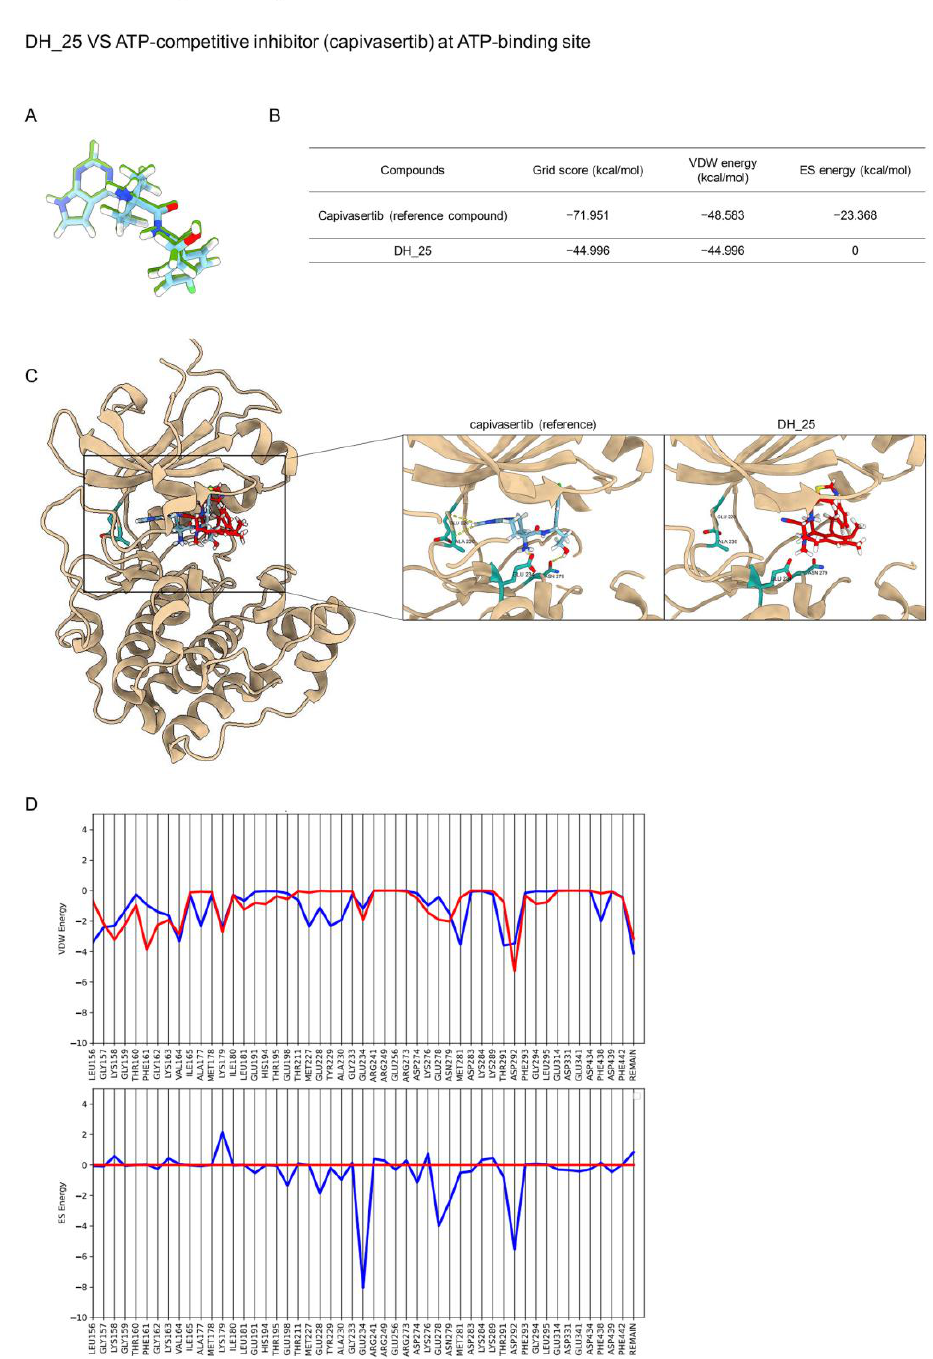
Figure 5. Molecular docking of DH_25 and Akt at the ATP-binding site compared with the ATP-competitive inhibitor (capivasertib). ( A ) Structural superimposition of redocked (blue) and experimental native ligands (green) at the active site of the ATP-binding pocket. ( B ) Binding energies of the ligand in complex with the ATP-binding site of Akt. ( C ) The ATP-binding site of Akt complexed with DH_25 or capivasertib, for reference. The yellow dashed lines denote hydrogen-bonding interactions. ( D ) Footprint analysis for DH_25 (red lines) compared with the capivasertib reference (blue lines) into the ATP-binding site of Akt.